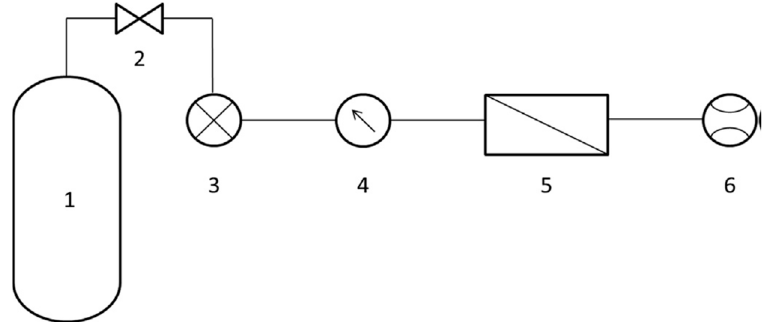
Figure 2. Permeability system: ( 1 ) CO 2 gas bottle, ( 2 ) valve, ( 3 ) pressure transducer, ( 4 ) manometer, ( 5 ) steel module containing membrane, ( 6 ) gas flow meter .